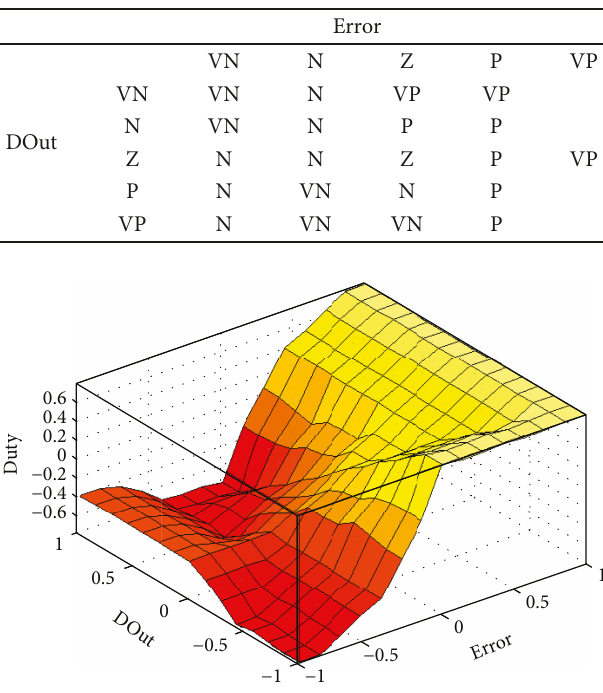
Table 1: AND-type fuzzy